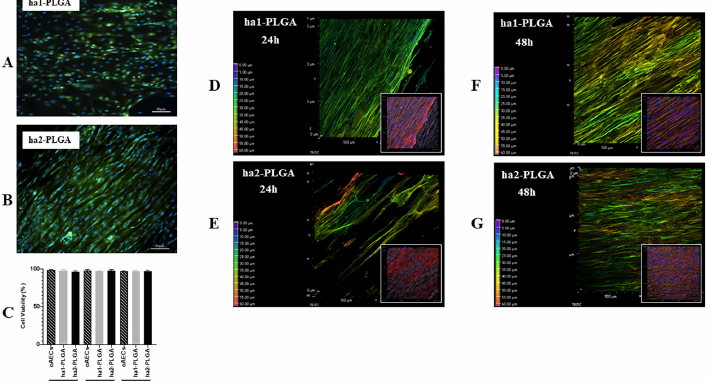
Figure 6. Amniotic Epithelial Stem Cell (AEC) viability and distribution on ha1- and ha2-PLGA fleeces. ( A , B ) Representative images assessing oAECs survival after 7 days culture on both types of fleeces with Calcein AM / propidium iodide (PI) stains (green and red fluorescence, respectively) where only viable cells are visible in green. Nuclei were counterstained with Hoechst 3342 (blue fluorescence). Scale bars = 50 µ m ( C ) Histogram showing oAECs viability of cells seeded on ha1-PLGA or ha2-PLGA fleeces after 24 h, 48 h, and 7 days culture. No statistical di ff erence was evident among the three groups ( p > 0.05); (n = 3 for each type of fleece / time point, fleece size: 15 mm × 7 mm). ( D – G ) Representative XY confocal images showing oAECs distribution within ha1-PLGA and ha2-PLGA fleeces after 24 h and 48 h culture. The depth coded MaxIP analysis was used to assess cell penetration within the fleeces, visible as light background, by defining the gradient color related to the direction of the cells. The purple color of the gradient scale refers to the surface of the fleece, while the red color is attributed to the bottom of the surface. Thus, the most superficial cytoplasm cells are shown with green color, whereas the cytoplasm of the cells present at the bottom of the fleece are shown in red. It also is evident that oAECs have an optimal distribution within the fleeces, especially in ha2-PLGA after 24 h culture, while no di ff erences were recorded between ha1- and ha2-PLGA fleeces in cell penetration after 48 h culture. The insets show the same phalloidin marked cell microphotographs that were analyzed with the MaxIP. In these images is evident the fusiform morphology of the cells attached to the aligned fibers. Fleeces captured from bright field exposition show that cells were disposed of parallelly oriented to the fibers. Scale bar = 50 µ